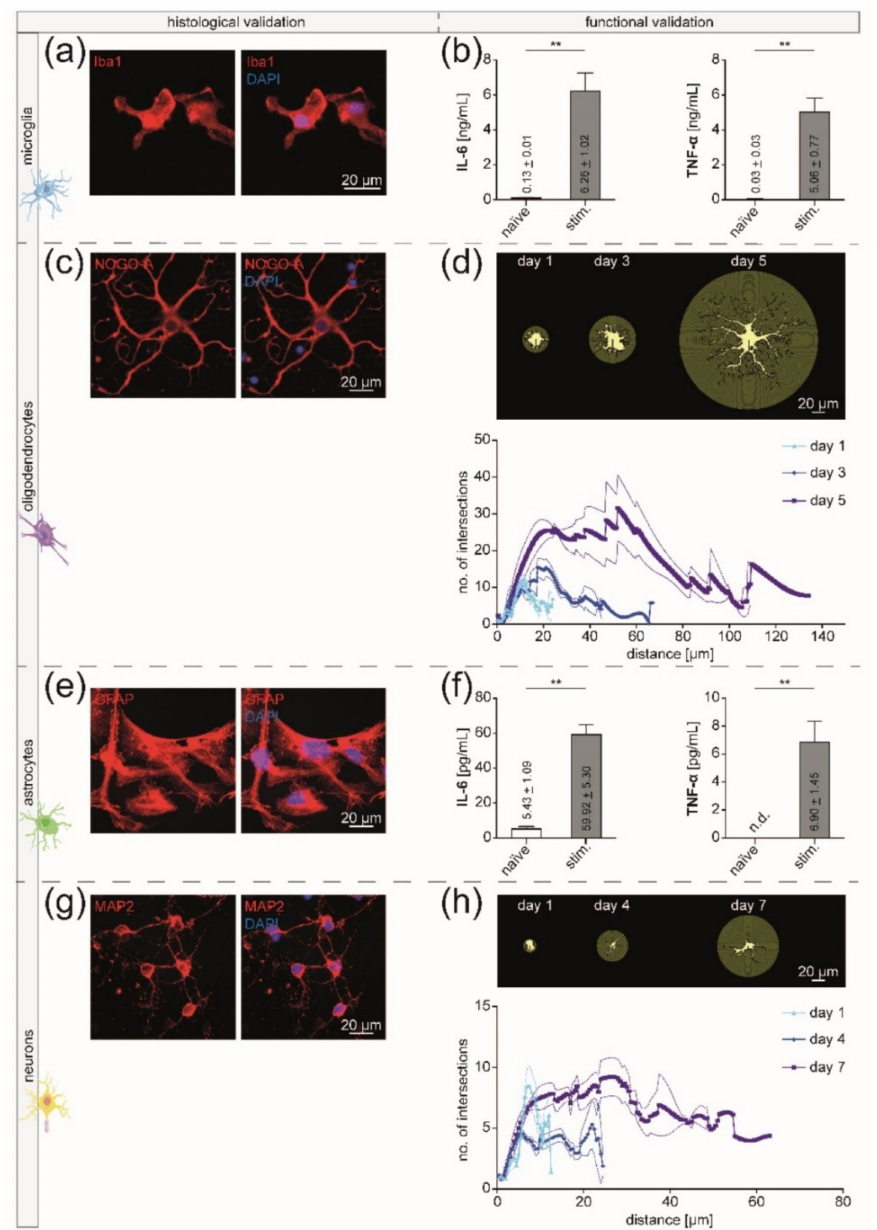
Figure 6. Viability of isolated adult CNS-resident cells after MACS. ( a , c , e , g ) Histological validation of the four isolated CNS-resident cell types using immunocytochemistry. Fluorescence images were acquired with a Zeiss Axio Scope.A1 using 40- ( c , e , g ) or 63- ( a ) fold objectives and optimal exposure times. ( b , d , f , h ) Functional validation of the four cell types by analyzing the change in their cytokine expression profiles upon stimulation ( b , f ) and observing their morphological development during cultivation ( d , h ). ( a ) Immunofluorescence staining of microglia with a primary antibody directed against Iba-1. ( b ) The expression levels of the pro-inflammatory cytokines IL-6 and TNF- α by microglia were significantly increased after stimulation with 100 ng/mL LPS for 48 h.